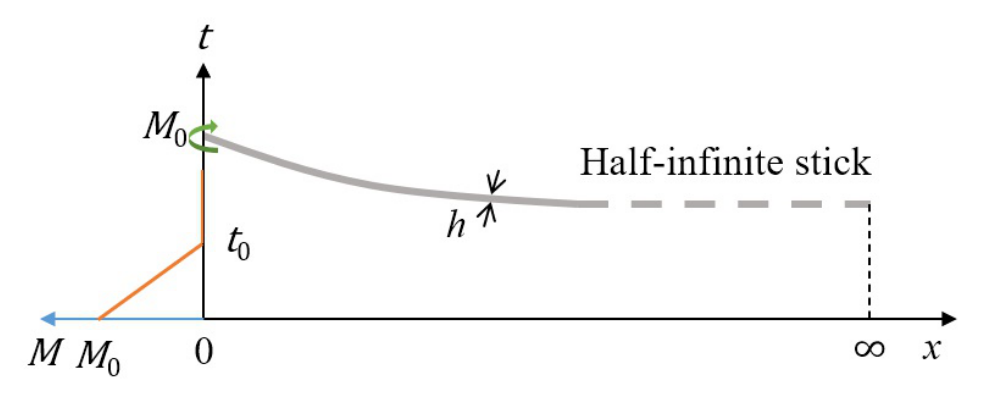
Figure 2. Schematic of the half-infinite gradual release model that mimics the secondary